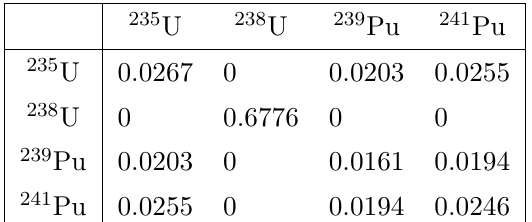
Table 3 . Covariance matrix of the cross sections per (cid:12)ssion of the four (cid:12)ssionable isotopes.